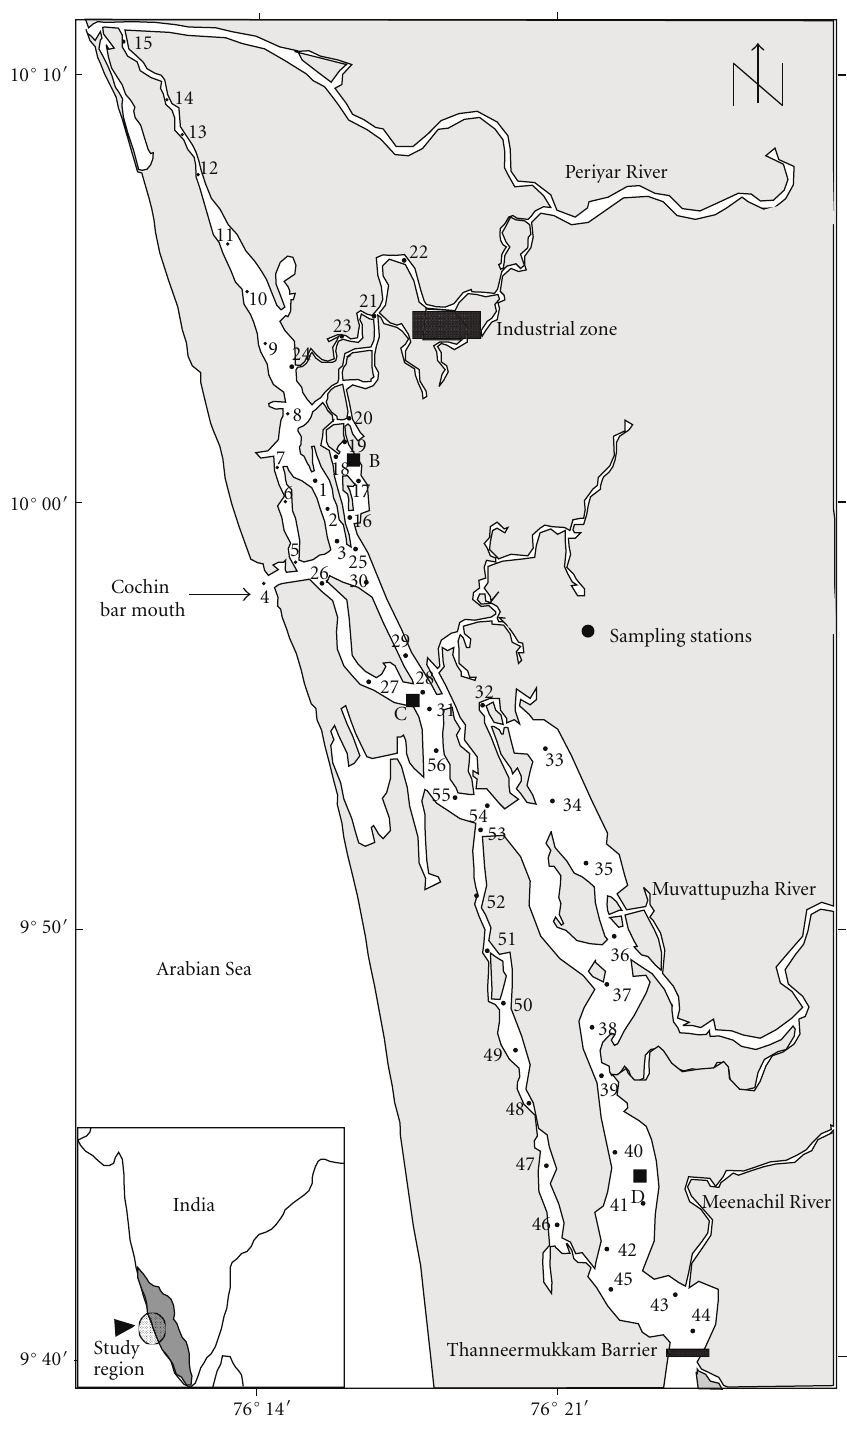
Figure 1: Map of the Cochin estuary with sampling